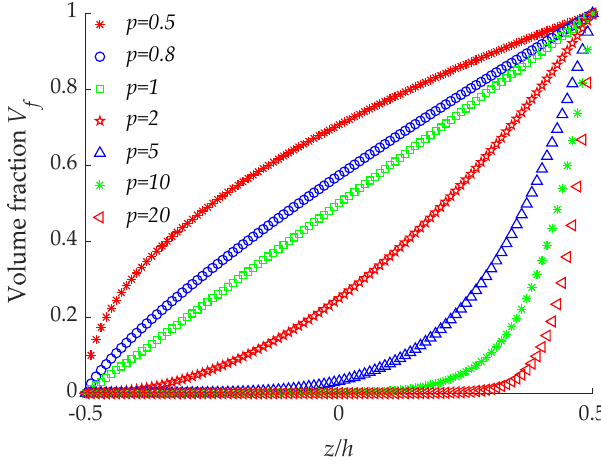
Figure 2. Variation of volume fraction with different gradient index.